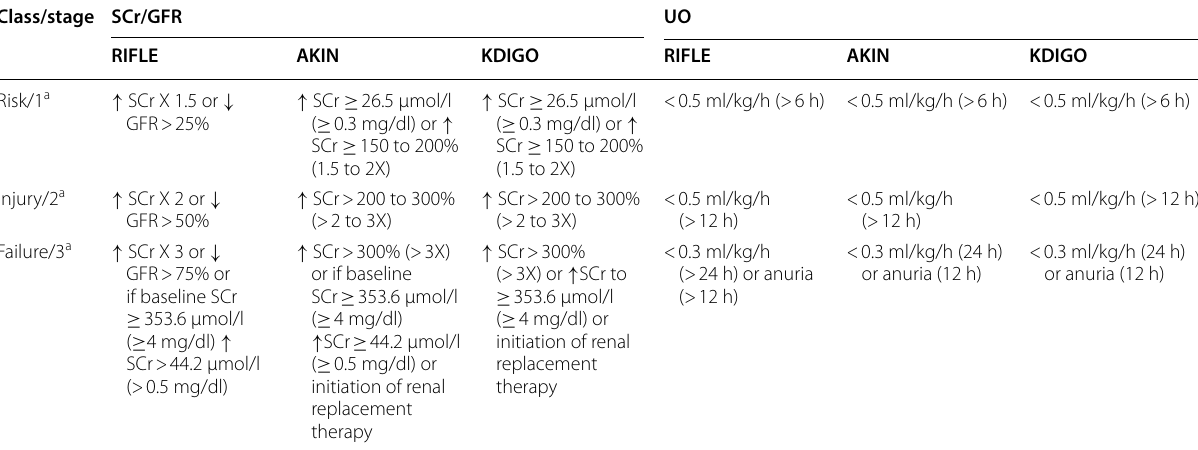
Table 2 Risk, injury, failure, loss of kidney function, End-stage kidney disease (RIFLE) [11], Acute Kidney Injury Network (AKIN) [7], and Kidney Disease Improving Global Outcomes (KDIGO) [12]